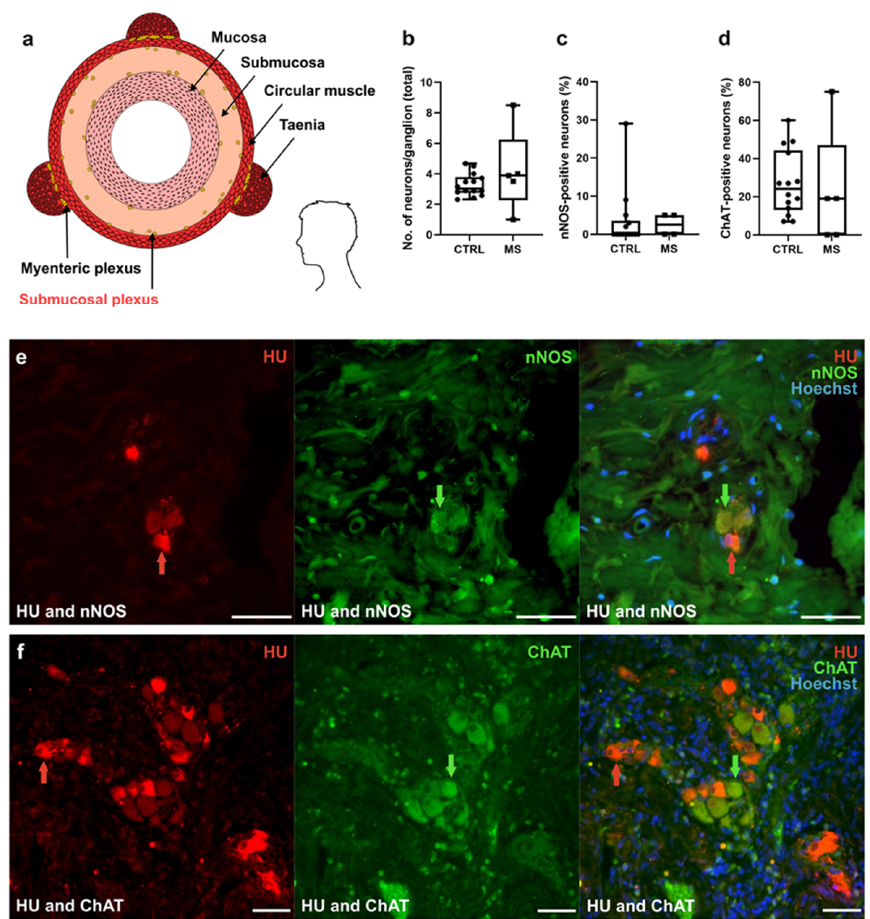
Figure 4. Immunohistological staining of the submucosal plexus (SP) of patients with multiple sclerosis (MS) ( n = 4–5) and non-MS controls (CTRLs) ( n = 14). ( a ) Paraffin-embedded human colon tissue was obtained from patients with MS and matched CTRLs. ( b ) Numbers of neurons per ganglion analyzed in each group. ( c , d ) Percentage of ( c ) neuronal nitric oxide synthase (nNOS) + and ( d ) choline acetyltransferase (ChAT) + neurons. Individual data points are patient mean values. The box and whisker plots show median values together with the interquartile range. For normally distributed data, statistical significance was determined by unpaired Student’s t test; otherwise, the Mann–Whitney U test was applied. ( e , f ) Representative images of the SP showing staining for ( e ) anti-HuC/D (HU) ( red arrow , first picture from the left) and nNOS ( green arrow , second picture from the left), combined with Hoechst 33258 (third picture from the left), and ( f ) HU ( red arrow , first picture from the left) and ChAT ( green arrow , second picture from the left), combined with Hoechst 33258 (third picture from the left). Scale bars denote 50 µ